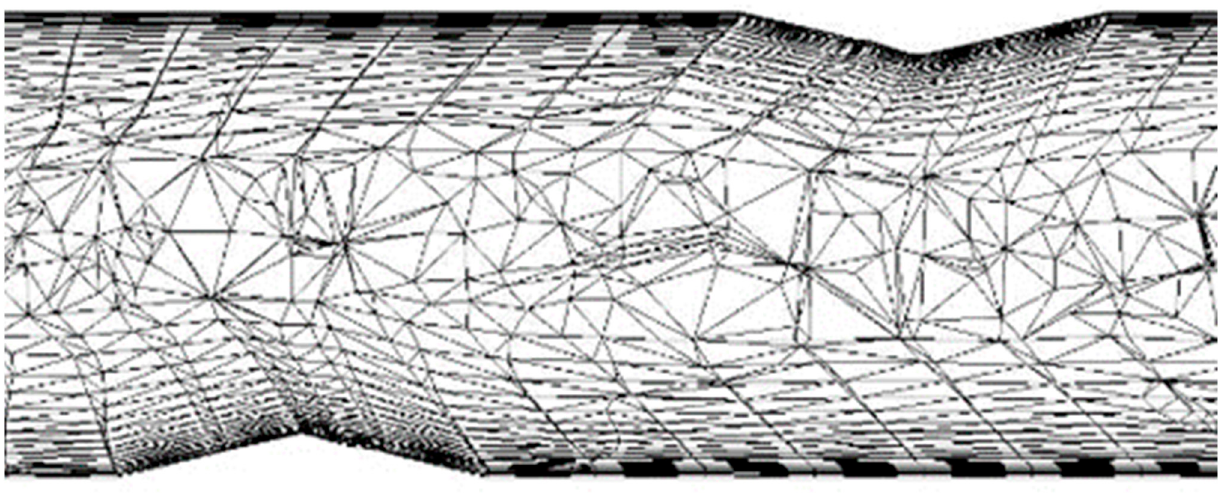
Figure 5. Detail of the CFD mesh of the tubes used in this part of this study.